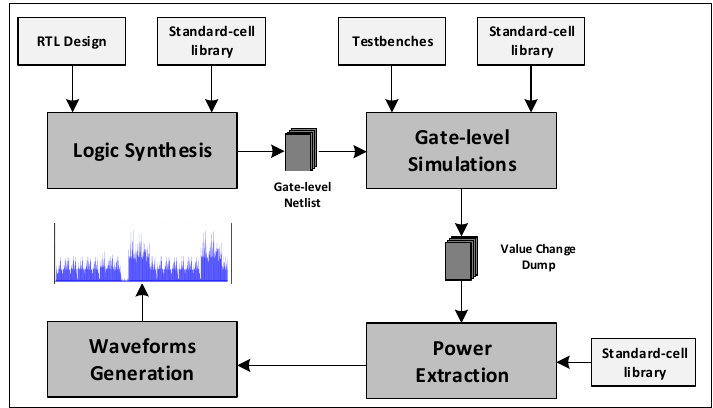
Figure 6. Power Simulation Flow for SPA